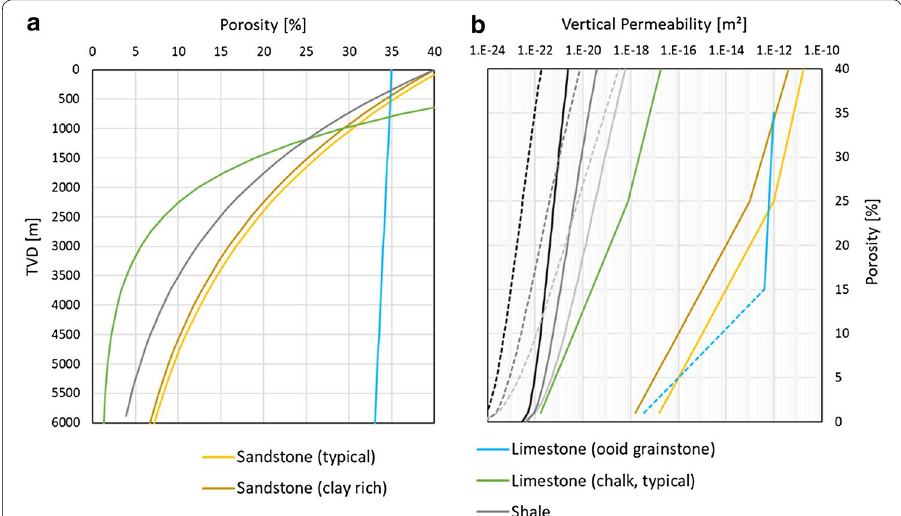
Fig. 5 Compaction and permeability relationships used in this study. a Porosity vs. true vertical depth (TVD). Relationships for sandstone (typical), sandstone (clay rich), limestone (ooid grainstone) and limestone (chalk, typical) are modeled with Athy’s porosity–depth function (Athy 1930) and input parameters provided by Hantschel and Kauerauf (2009). Shale compaction has been modeled with Athy’s relationship modified for effective stress (for this plot hydrostatic pressure is assumed) and input parameters after Drews et al. (2018). b Vertical permeability as a function of porosity. Relationships for sandstone (typical), sandstone (clay rich), limestone (ooid grainstone) and limestone (chalk, typical) are modeled using three-point relationships after Hantschel and Kauerauf (2009). Shale permeability has been modeled with the empirical relationship after Yang and Aplin (2010) displayed for clay contents of 50% (light grey line), 70% (dark grey line) and 90% (black line). The dashed grey and black lines represent the 2-phase correction from Busch and Amann-Hildenbrand (2013) applied to shale permeabilities derived from the relationship from Yang and Aplin (2010) displayed for clay contents of 50% (light grey dashed line), 70% (dark grey dashed line) and 90% (black dashed